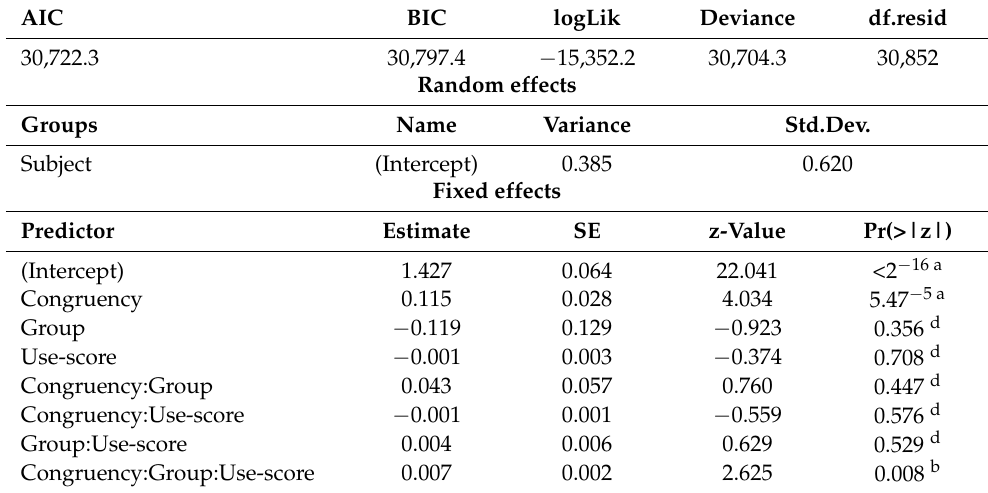
Table 2. Summary of random and fixed effects (ACC) when the subject-specific use scores were included in the statistical model (exploratory